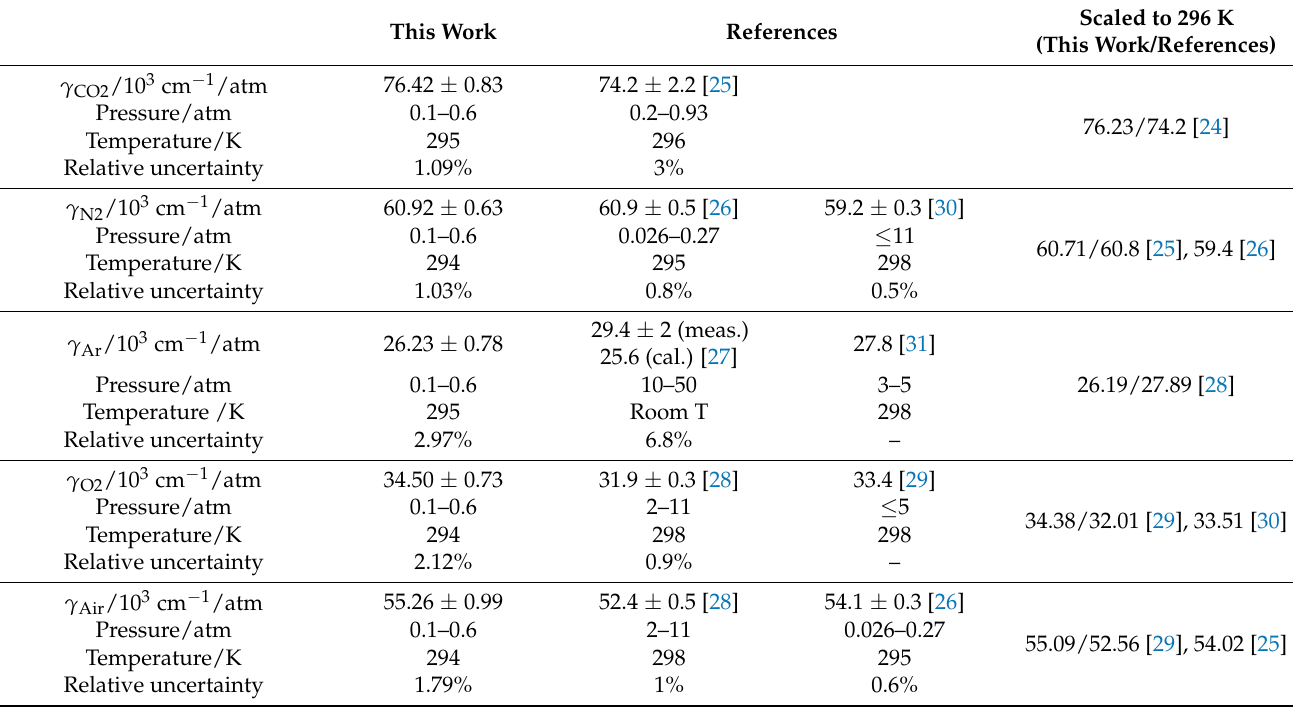
Table 1. Comparison of our results with data from the literature for the foreign broadening coefficients of HCl P(5) (1 ← 0) absorption line with CO 2 , N 2 , Ar, O 2 and